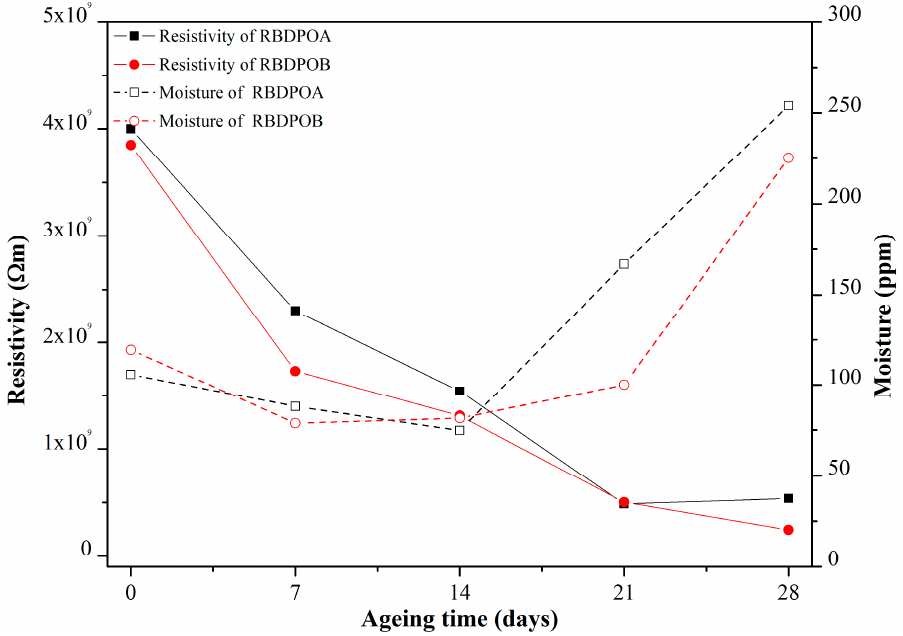
Figure 12. Relationship between resistivity and moisture of RBDPO aged at 170 °C under open conditions.